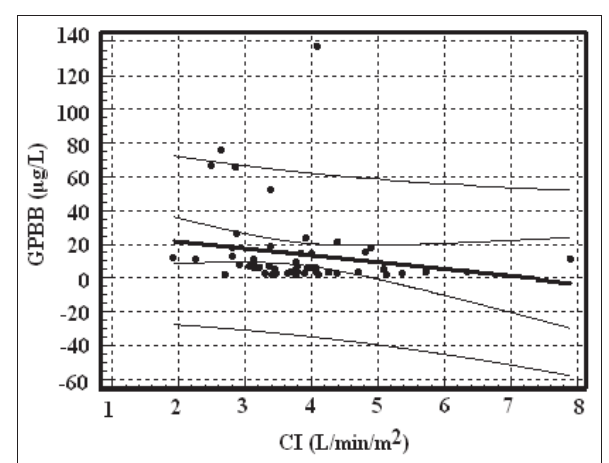
Fig. 1. Association of serum GPBB measured 24 h after TIPS with systemic vascular resistence (SVR) before TIPS.